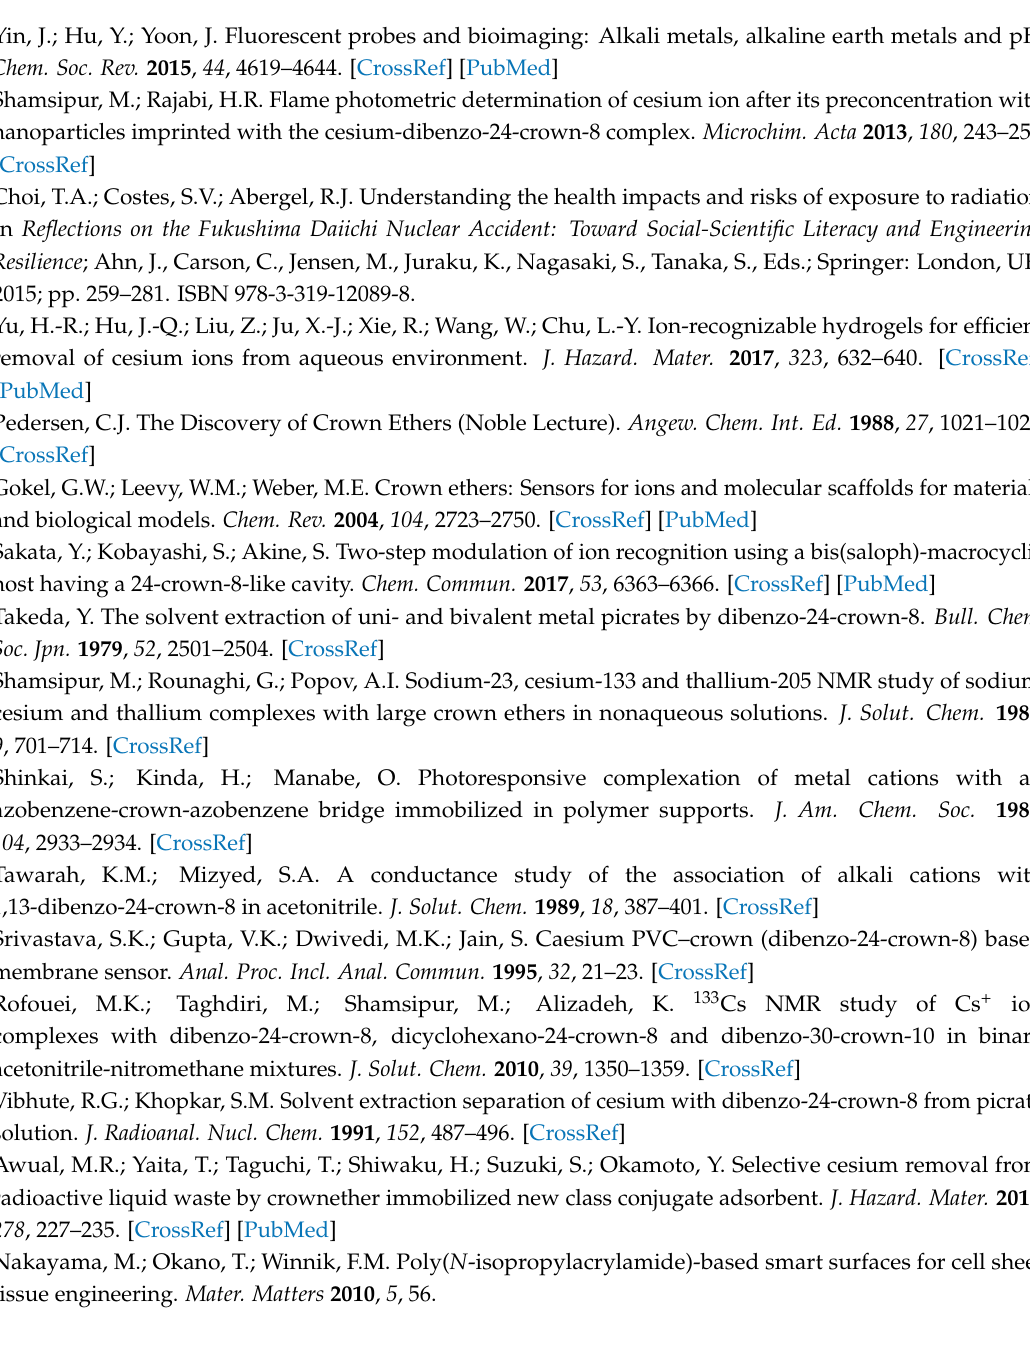
of alkali metal